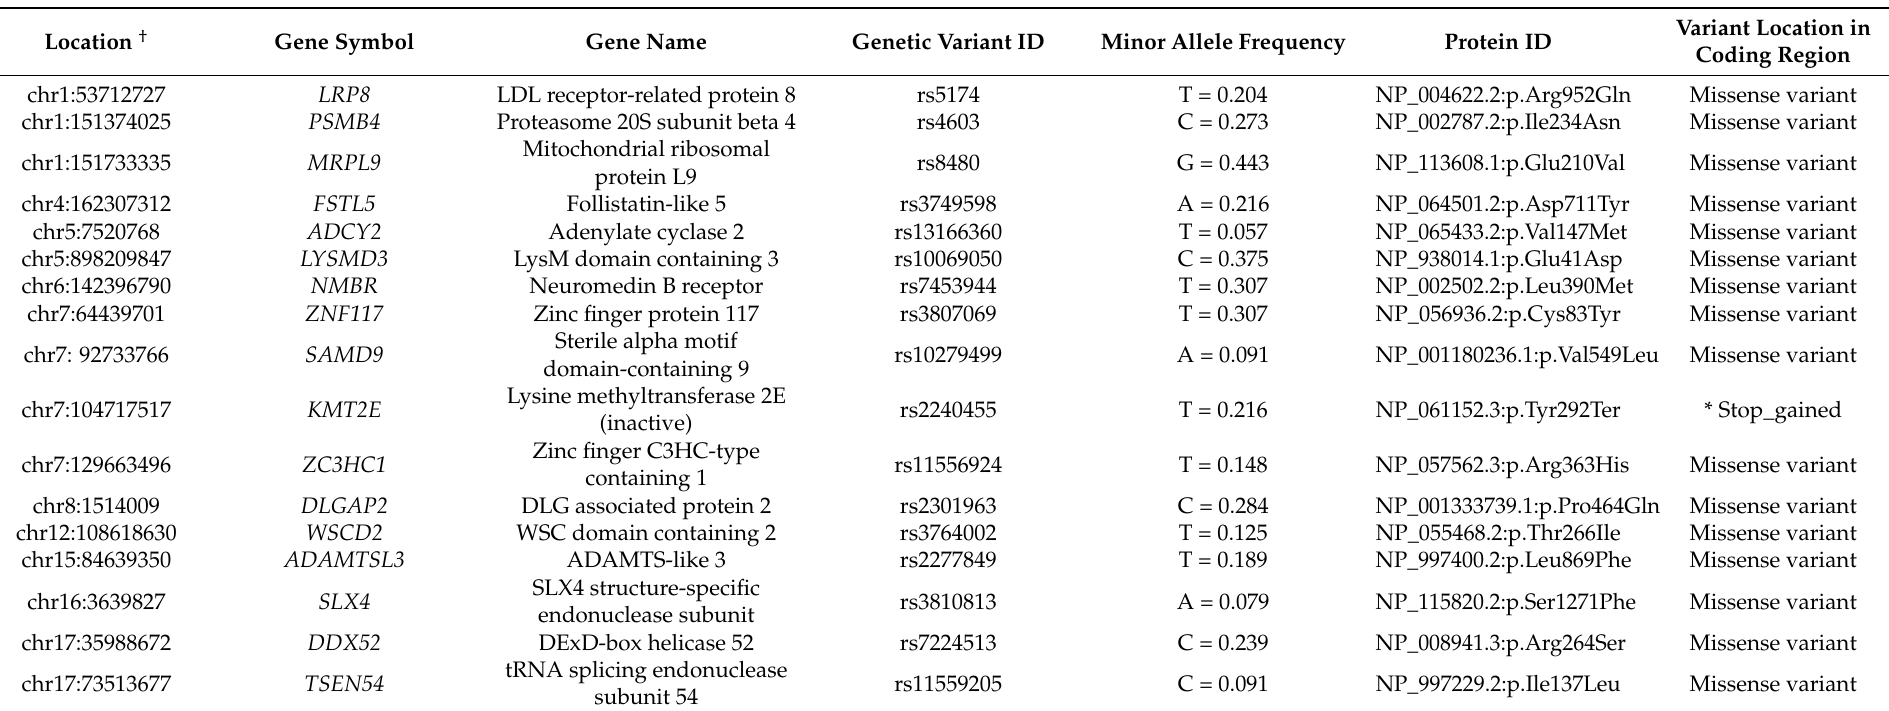
Variant Location in